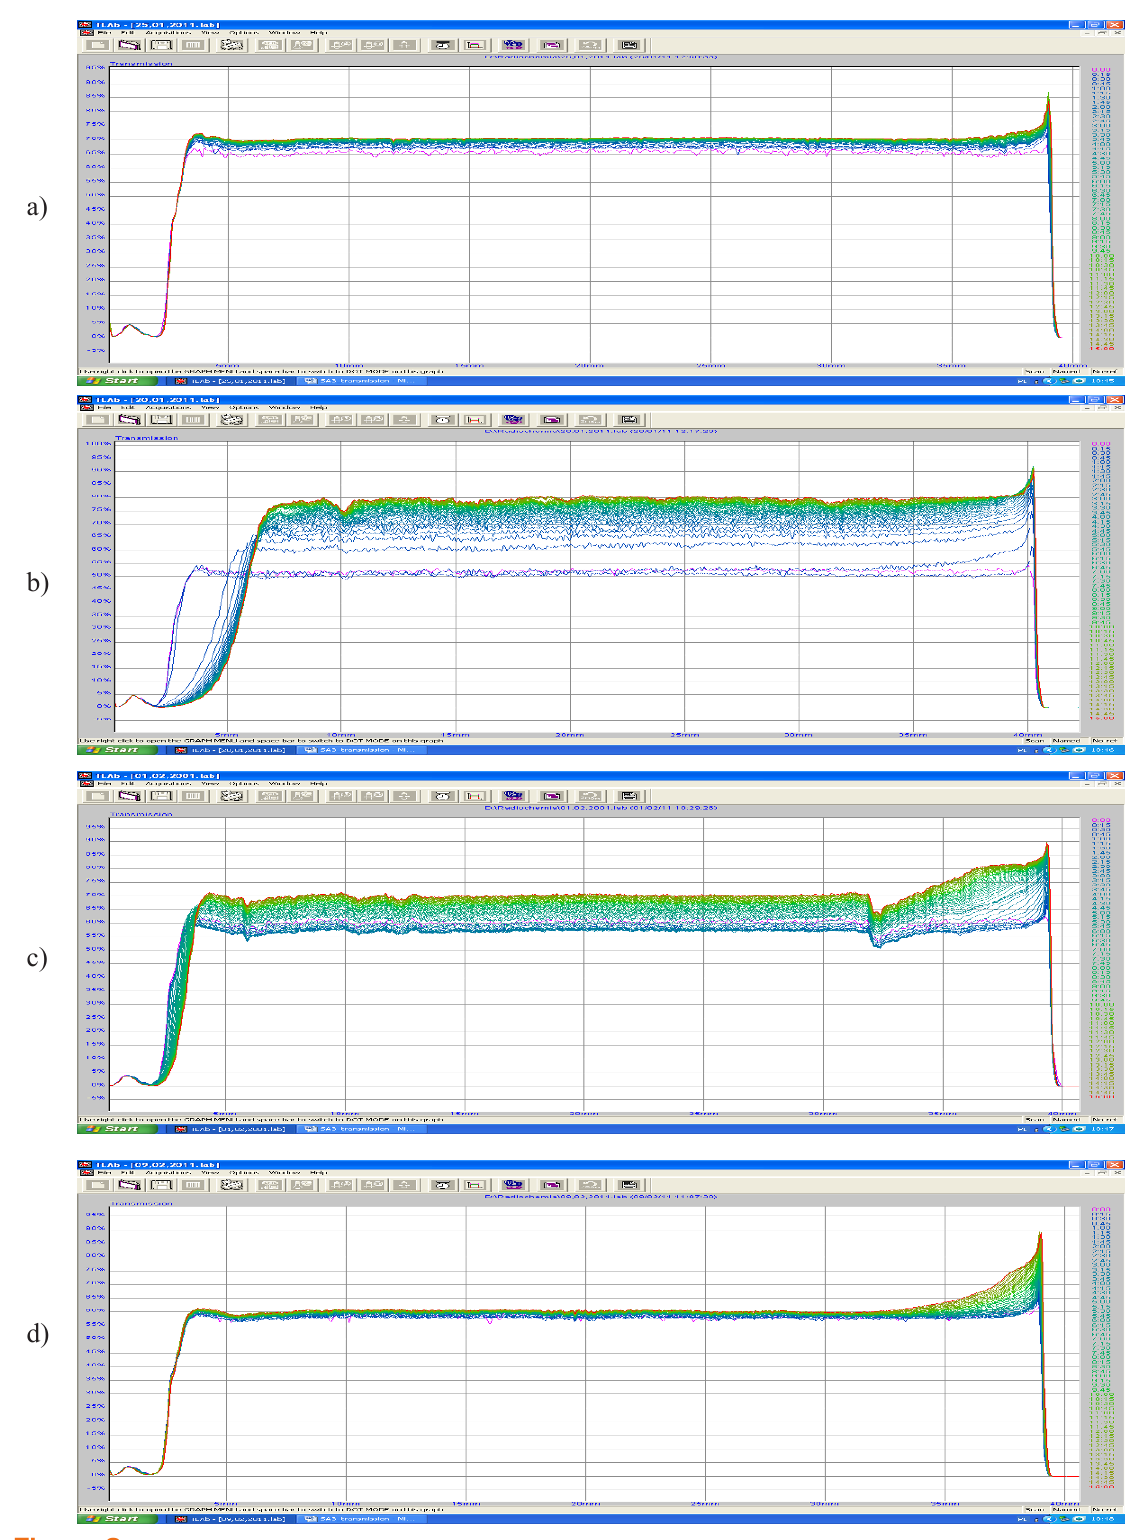
Figure 2. Transmission curves for systems: a) SA 3/NaCl, b) SA 3/NaCl/PAA 2000, c) SA 3/NaCl/PAA 100000, d) SA 3/NaCl/PAA 240000 at pH=6. The level of suspension in the measurement vial [mm] is along the x axis and the light intensity transmitted through the suspension [%] is along the y